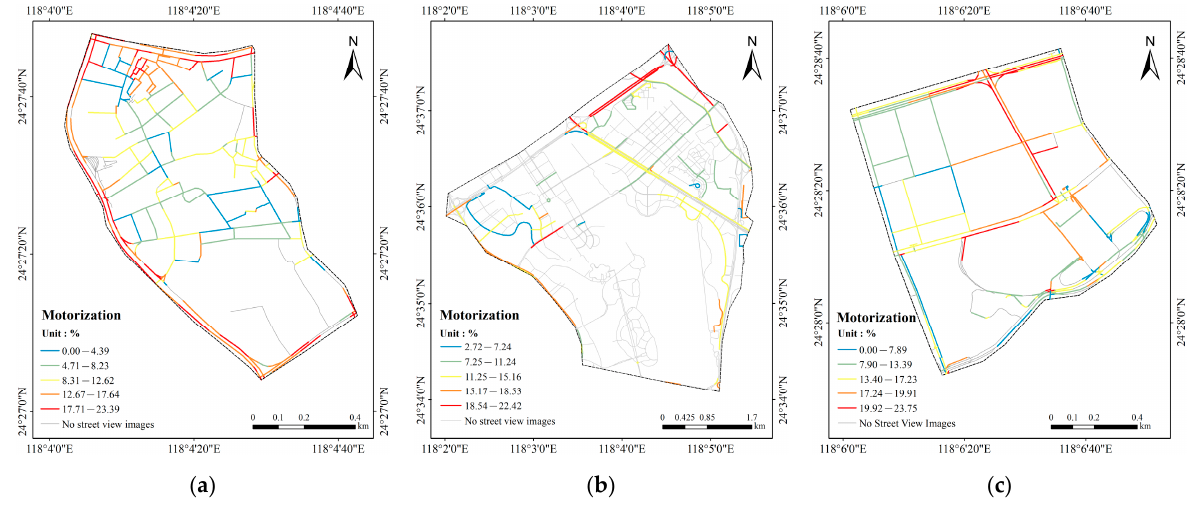
Figure 11. Visualisation results of motorization in ( a ) Area Ⅰ , ( b ) Area Ⅱ , and ( c ) Area Ⅲ .